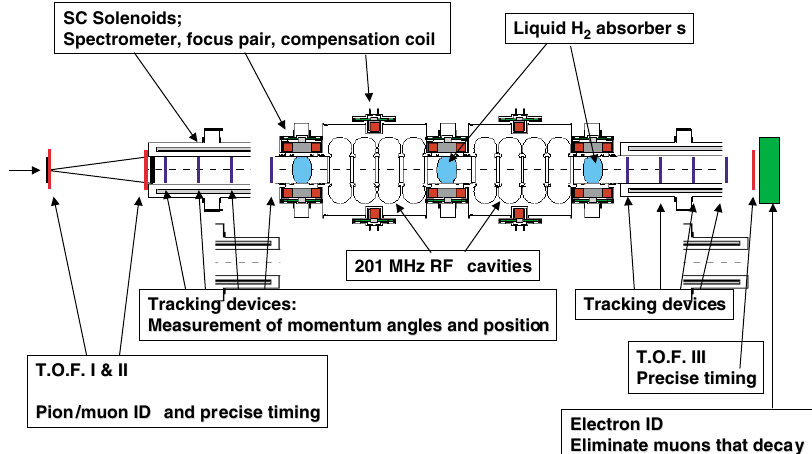
FIG. 47. (Color) Schematic layout of the MICE apparatus.